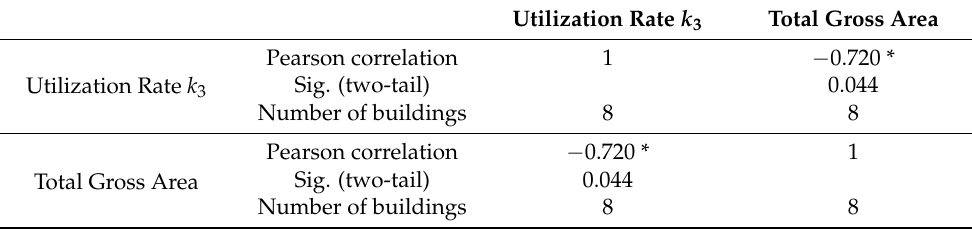
Table 10. Correlation between total gross area and the building utilization rate k 3